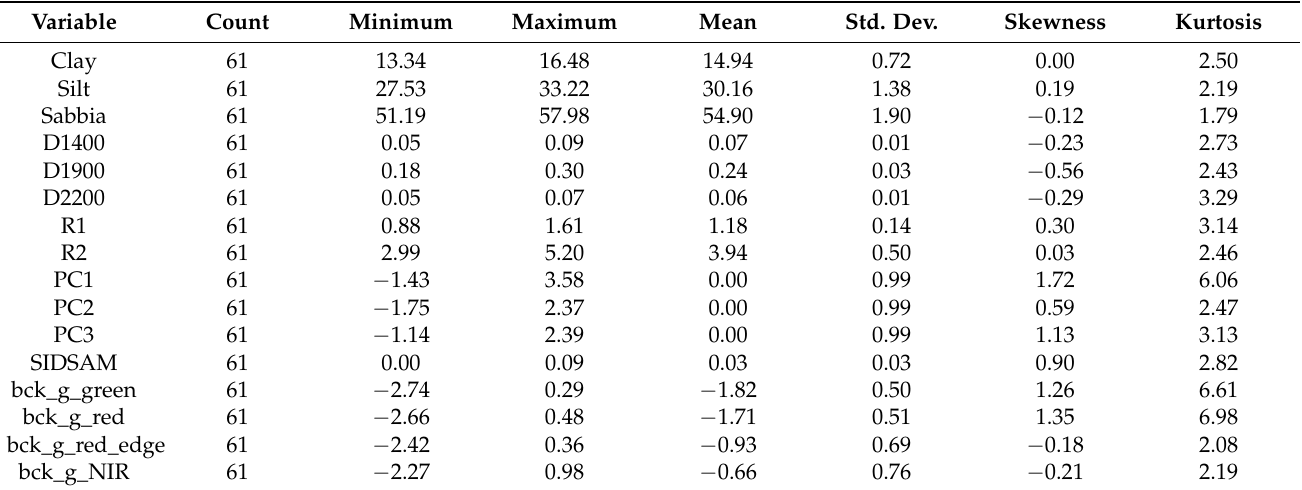
Table 4. The statistics of the complete coregionalization data set. bck before the name of the variable stands for block cokriging estimate.